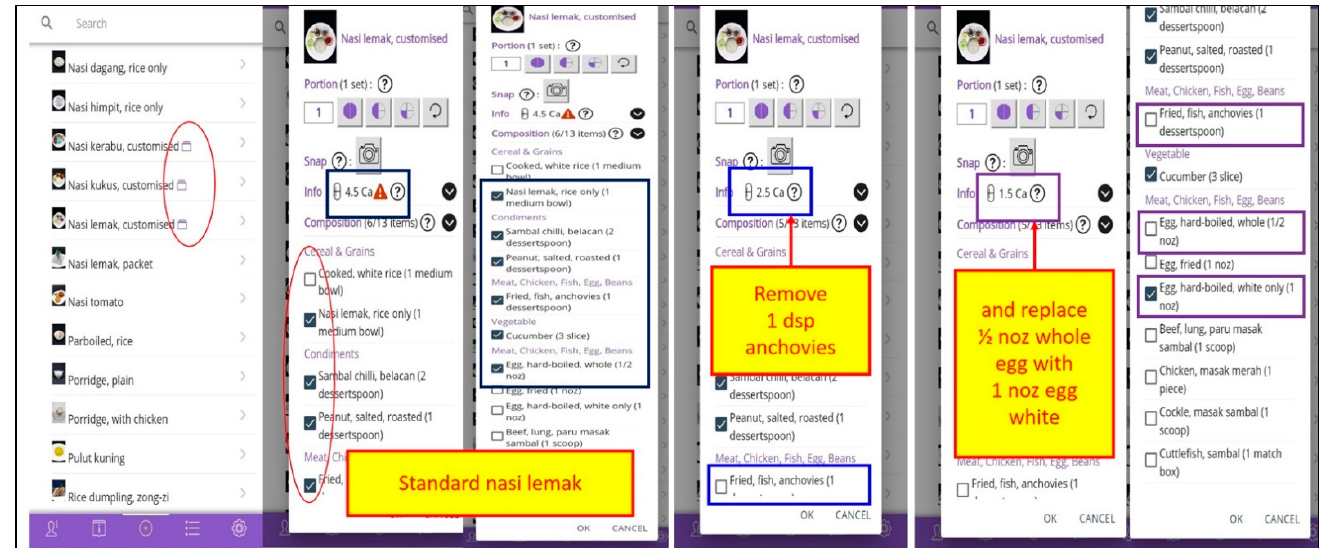
Figure 2. Interactive features of the MyKidneyDiet–Phosphate Tracker targeting lower dietary phos- phate load food item selection. Abbreviation: dsp, dessertspoon. phosphate load food item selection. Abbreviation: dsp,